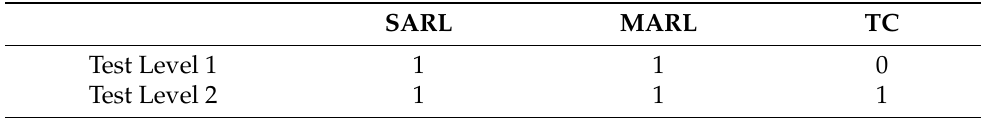
Table 7. This test plan elaborates on which experiments are necessary to prove scalability in MARL and better performance in Reinforcement Learning when comparing with traditional control